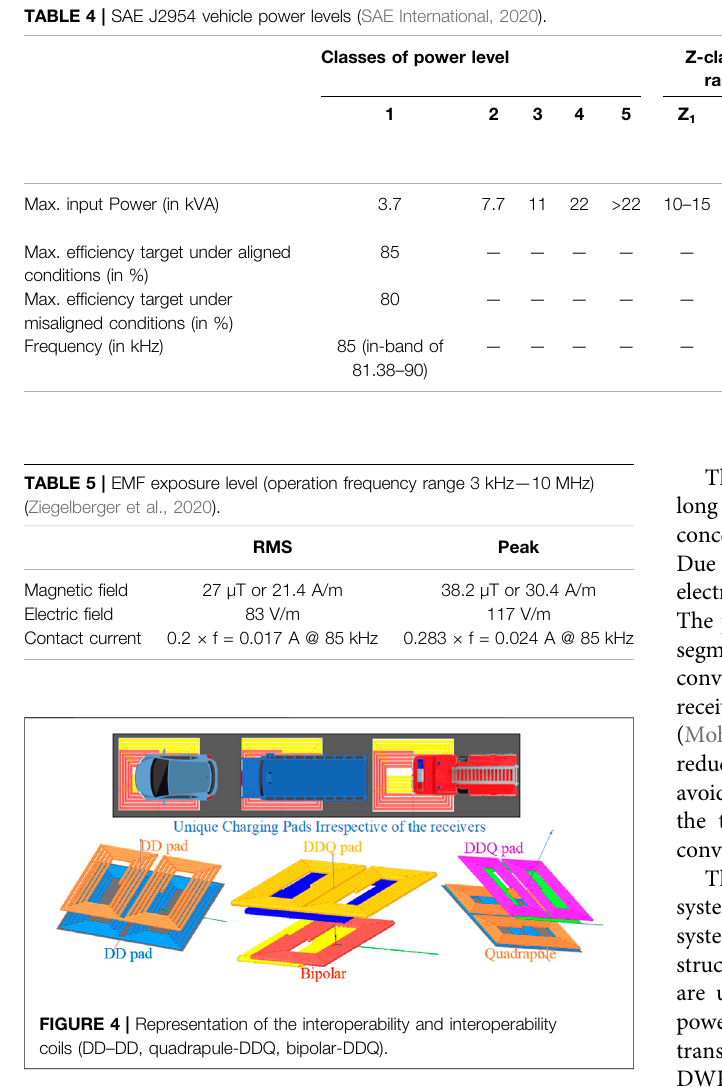
Frontiers in Energy Research |